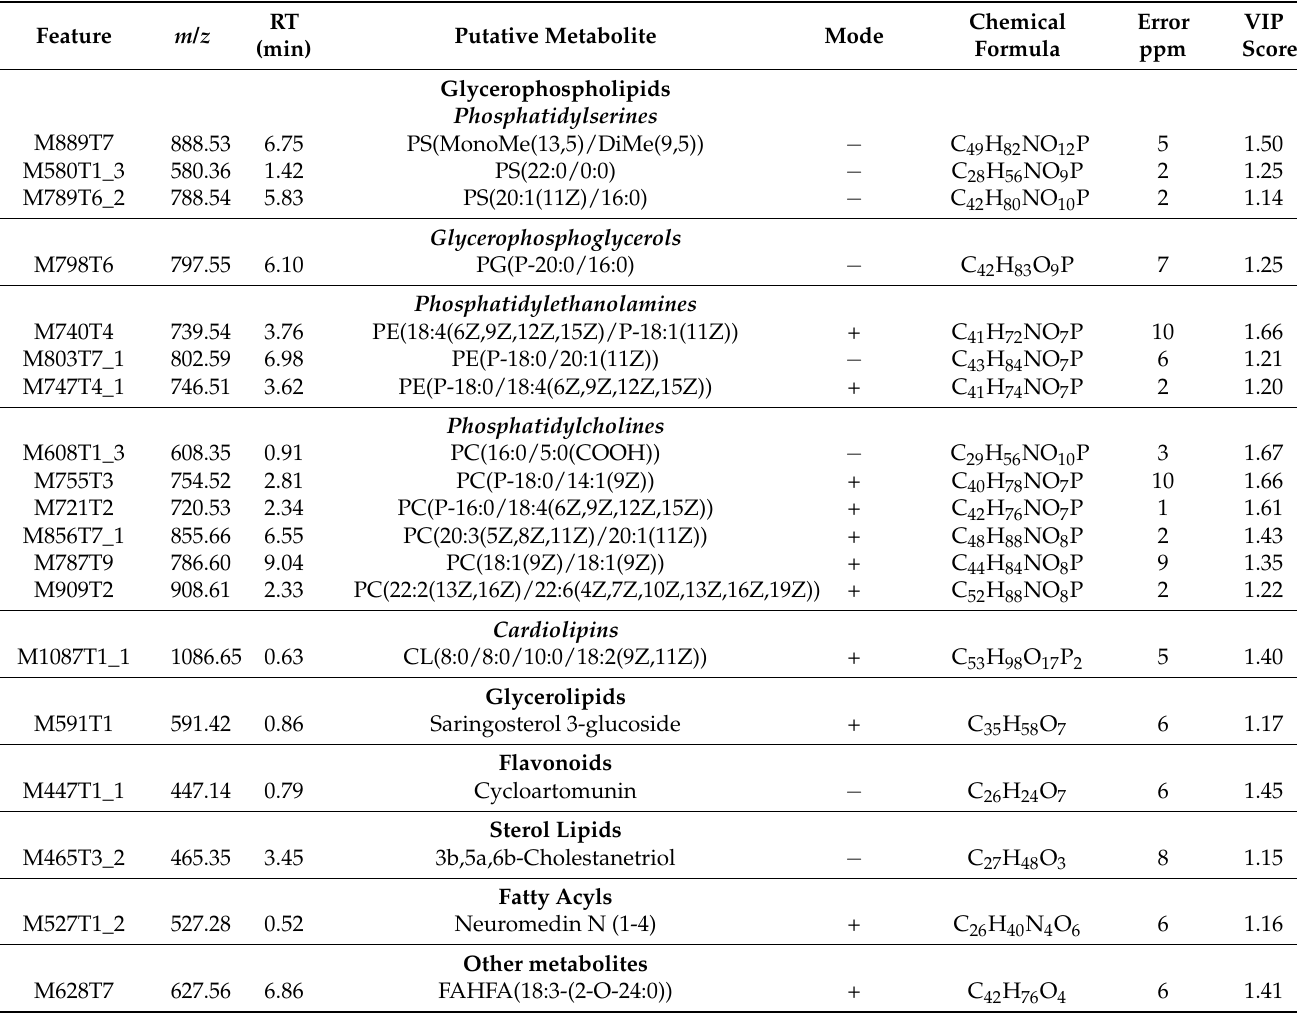
Table 3. Features annotated and selected by the analysis of VIP scores as the most capable of differentiating the elite and non-elite